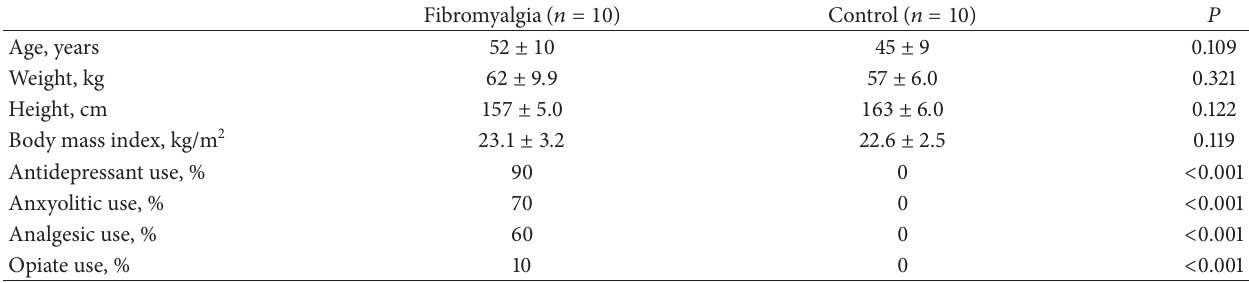
Table 1: Demographic, anthropometric, clinical, and medication use data in both